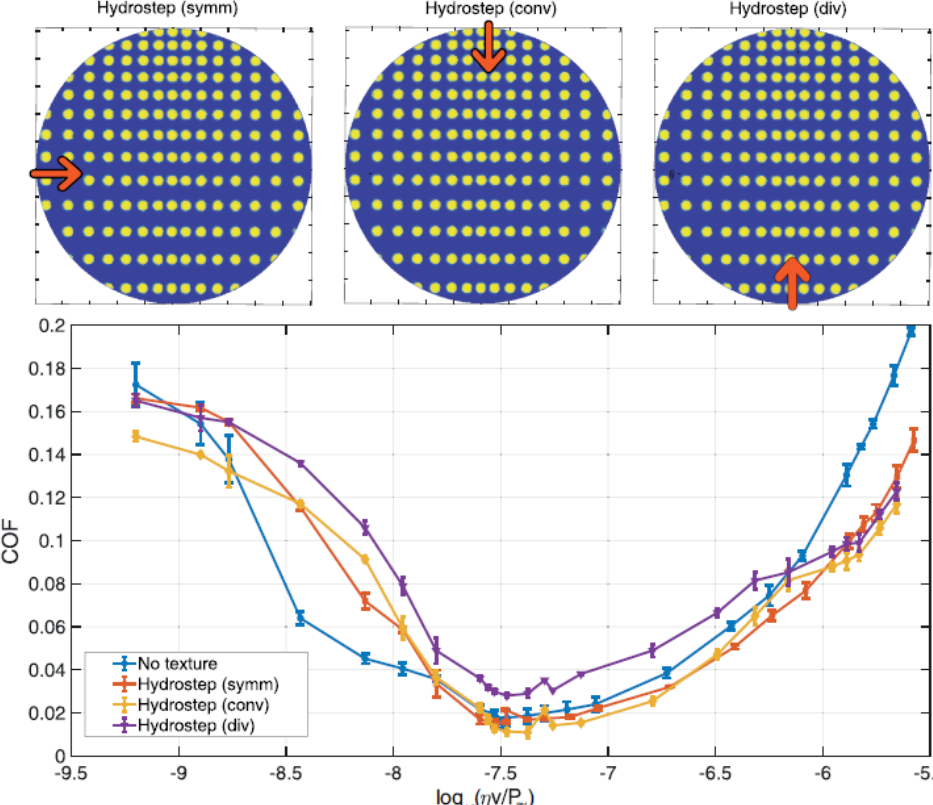
( η v / P av ) for the 10